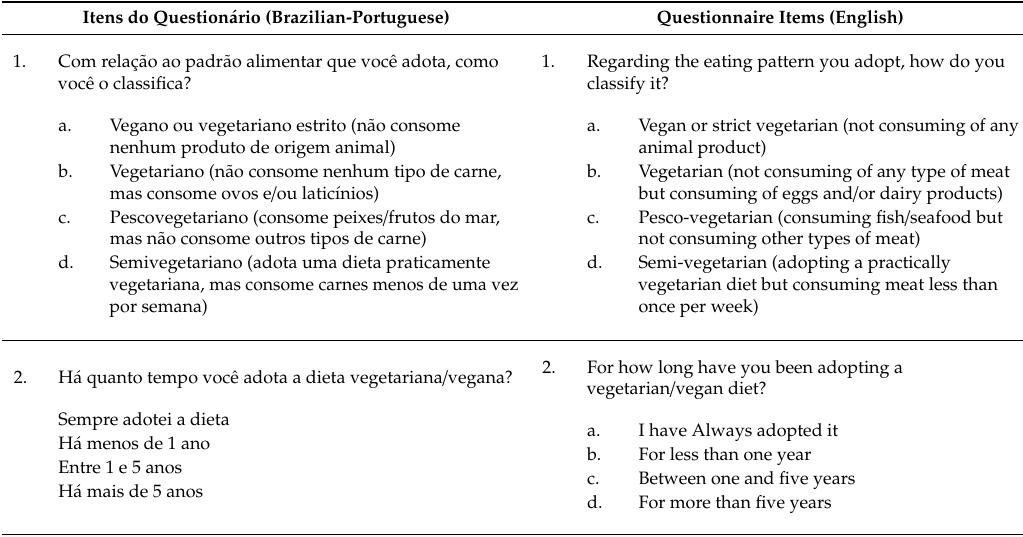
Table 1. Vegetarian Quality of Life Questionnaire (VEGQOL) (Brazilian-Portuguese version and free translation to